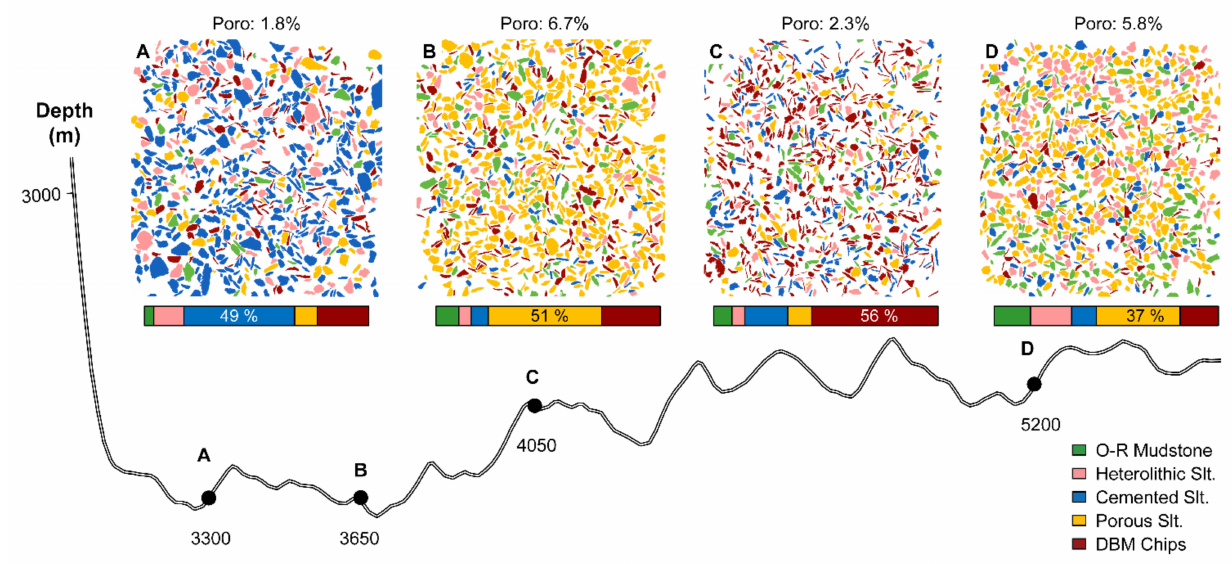
Figure 11. Colored images displaying the rock type classification conducted on SEM images from thin sections. The four examples ( A – D ) represent the lithological variations over Segments 1 ( A ), 4 ( B ), 5 ( C ), and 8 ( D ). The drill cutting chips are colored by rock type (see legend). The shown porosity corresponds to log-calculated